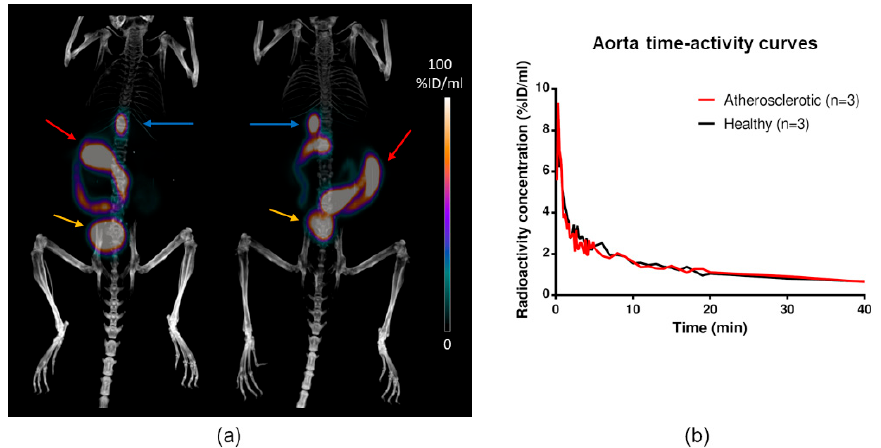
Figure 5. Examples of [ 18 F]Flutemetamol in vivo PET/CT images. ( a ) PET/CT of a healthy C57BL/6N mouse (left) and atherosclerotic IGF-II/LDLR − / − ApoB 100/100 mouse (right) at 30 min post-injection. High radioactivity is seen in the gallbladder (blue arrows), intestine (red arrows), and urinary bladder (yellow arrows). The kidneys are also faintly visible. ( b ) Time-activity curves in aorta show no difference between the atherosclerotic and healthy mice.